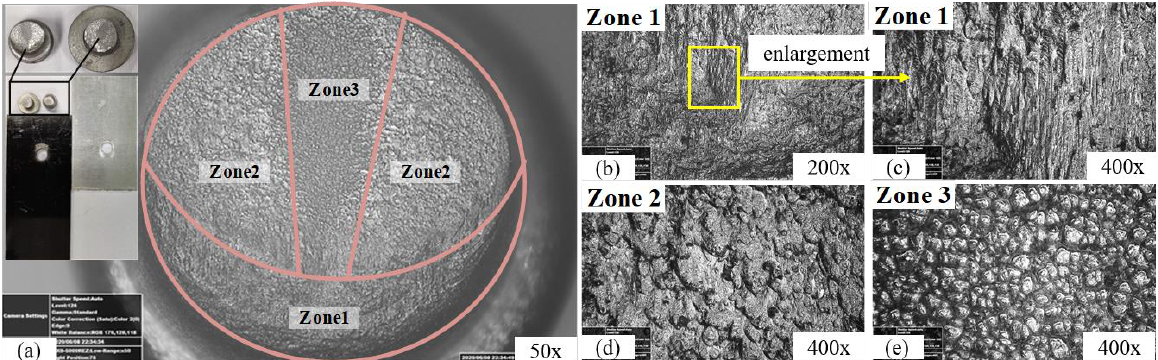
Figure 16. The fracture morphology the specimen with 66° TRM. ( a ) Observation diagram; ( b ) Zone 1 microtopography of Ti-alloy rivet; ( c ) the enlarged Zone 1 microtopography of Ti-alloy rivet; ( d ) Zone 2 microtopography of Ti-alloy rivet; ( e ) Zone 3 microtopography of Ti-alloy rivet.